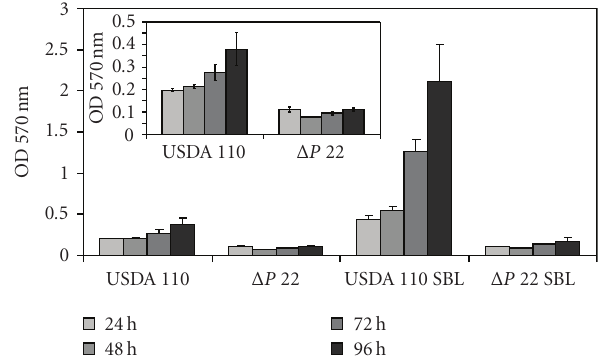
Figure 3: Optical density at 570 nm indicating biofilm formation in the microtiter plate assay by B. japonicum wild type strain USDA 110 or the EPS-defective derivative mutant Δ P22 with or without 300 μ g mL − 1 SBL at the indicated incubation times. In the inset the treatments without SBL are shown with a di ff erent scale in the ordinate axis for a better appreciation of the di ff erences between USDA 110 and Δ P22.